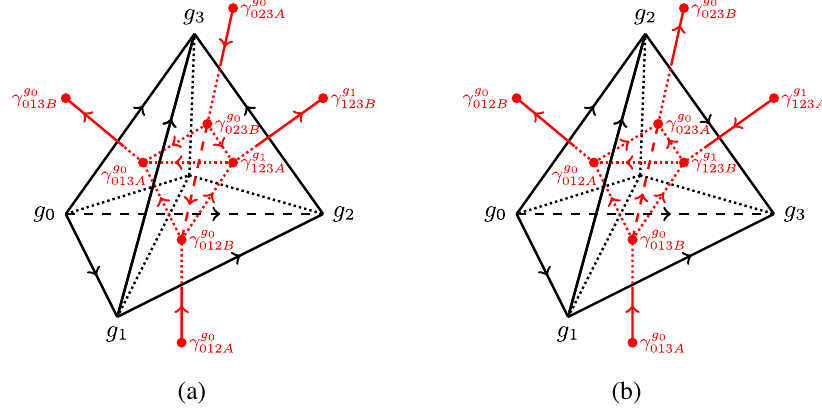
FIG. 9. Local Kasteleyn orientations of the resolved dual lattice. For a given triangulation of the 3D spatial spin manifold (shown by black links), we can construct a resolved dual lattice (shown by red links). The Majorana fermion pairings (in the standard tetrahedron) should respect the red link arrows in the figures. (a) Positive oriented tetrahedron (b) Negative oriented